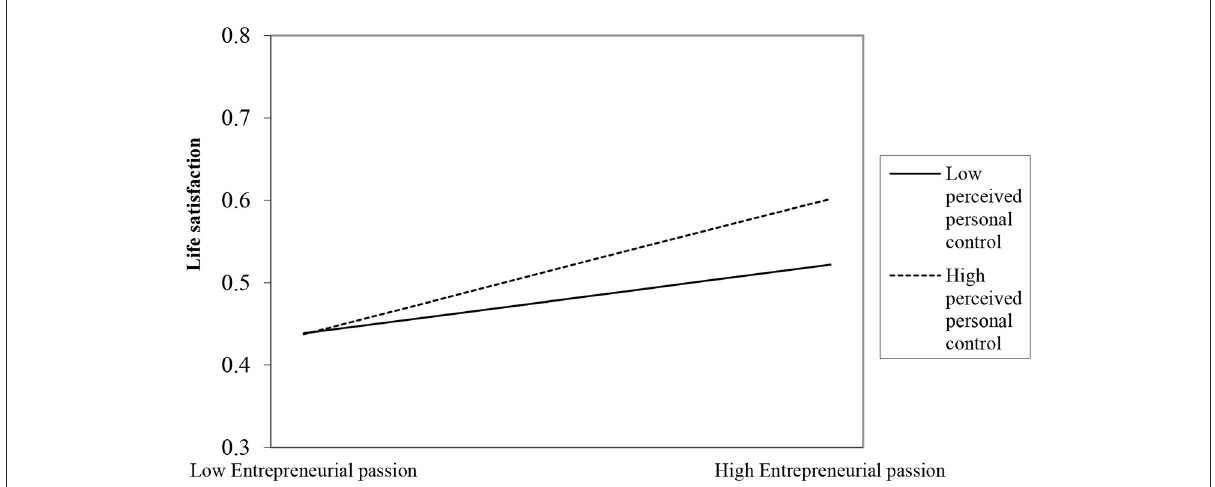
FIGURE2 The moderating effect of perceived personal control on entrepreneurial passion and life satisfaction.